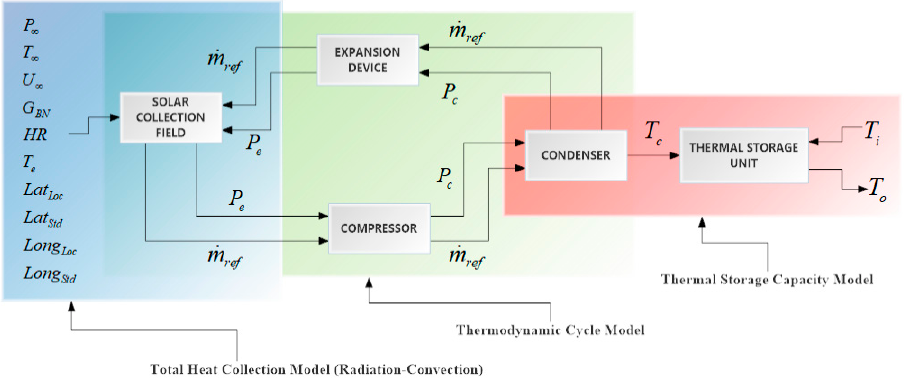
Figure 2. Causal diagram of the DXSAHP system.